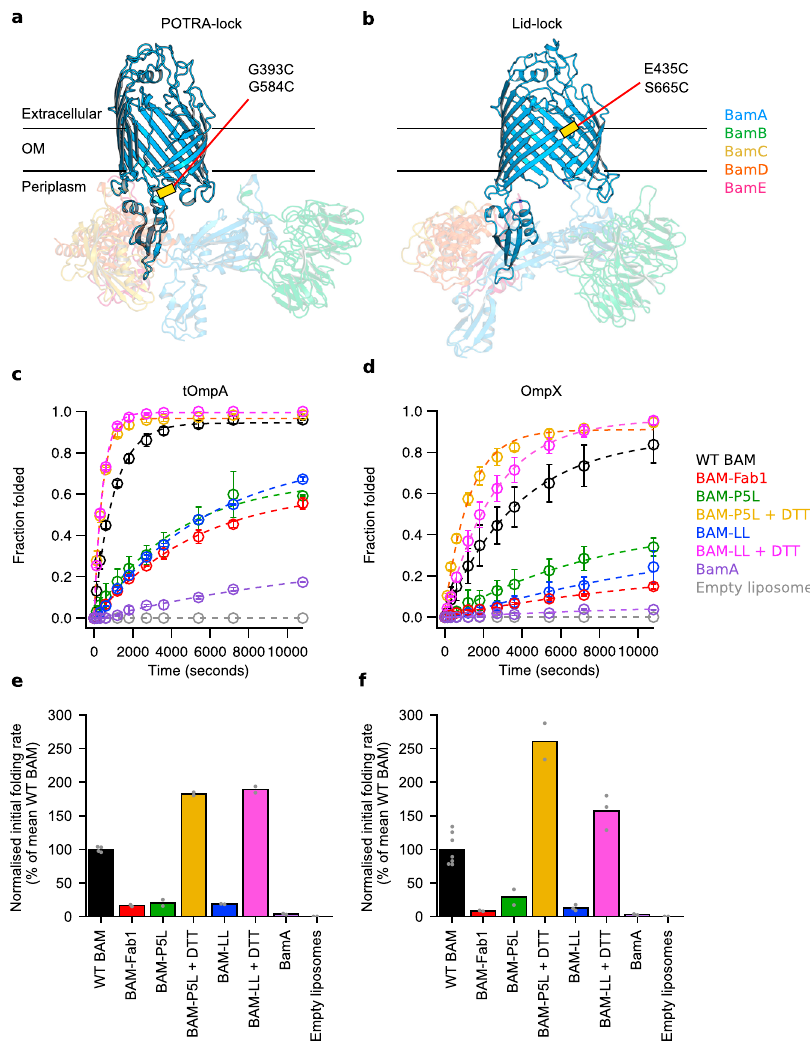
Fig. 1 Disul fi de-locked BamA variants and Fab1 binding impair BAM-mediated OMP folding in vitro. a BAM-P5L (G393C/G584C) is expected to lock BamA in the lateral-open conformation (PDB code 5LJO 8 ), while b BAM-LL (E435C/S665C) is expected to lock BamA in the lateral-closed conformation (PDB code 5D0O 6 ). BamA POTRAs 1 – 4 and BamBCDE are rendered semi-transparent for emphasis on the BamA β -barrel and POTRA-5. The position of the disul fi de bond is shown as a yellow bar. Figure made in PyMOL v1.7.2.3. c and d Quanti fi cation of folded and unfolded bands from SDS – PAGE band-shift assays (Supplementary Figs. 5 and 6) plotted as fraction folded against time for tOmpA or OmpX, respectively. Data markers represent the average folded fractions calculated from at least two repeats (the number of replicates is shown in Supplementary Table 1) and dashed lines are single exponential fi ts of the data. Error bars represent range of values covered by the replicates. e and f The initial rates of folding (determined by applying a linear fi t to the fi rst 5% of folding data) normalised as a percentage of the mean initial rate obtained for WT BAM, are shown for e tOmpA and f OmpX folding. Bars represent the mean value for each condition, with values for each replicate shown as grey points. Average initial rates, normalised data and ranges are listed in Supplementary Table 1. Folding yields after 24 h are reported in Supplementary Table 2. Figures labelled with “ BAM ” refer to the full BAM complex (BamABCDE), whilst “ BamA ” is just BamA alone. Source data for c – f are provided as a source data fi